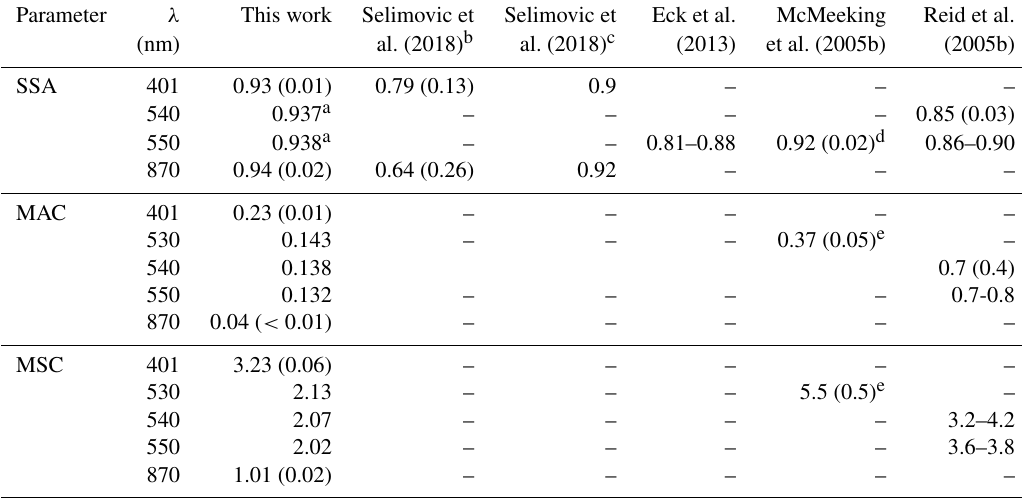
Table 4. Time-weighted study-average SSA, MAC, and MSC compared to other works.